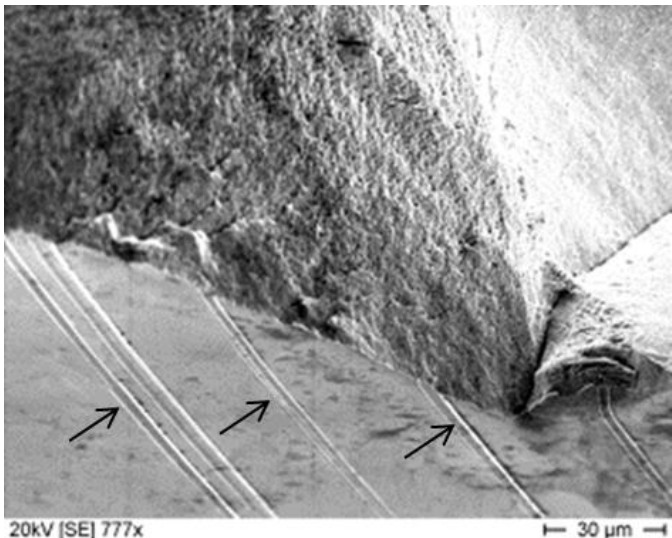
Figure 12. Shear bands visible at the sample’s surface in the area of the crack initiation